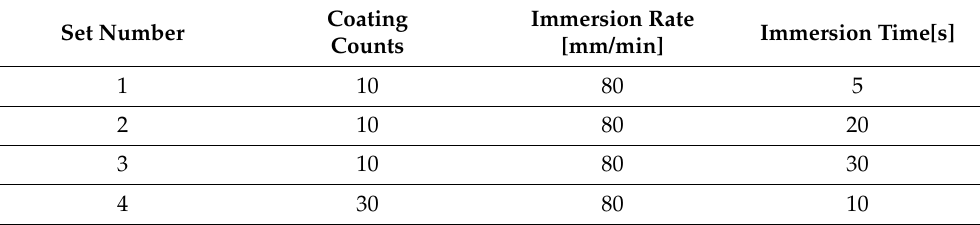
Table 7. The list of selected parameters of the dip-coating process for the best quality layers